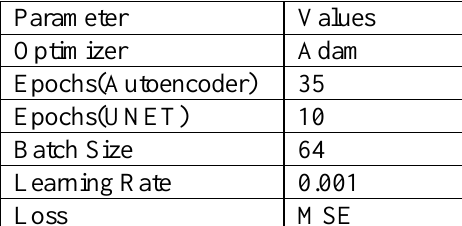
Table 1. Model hyperparameters